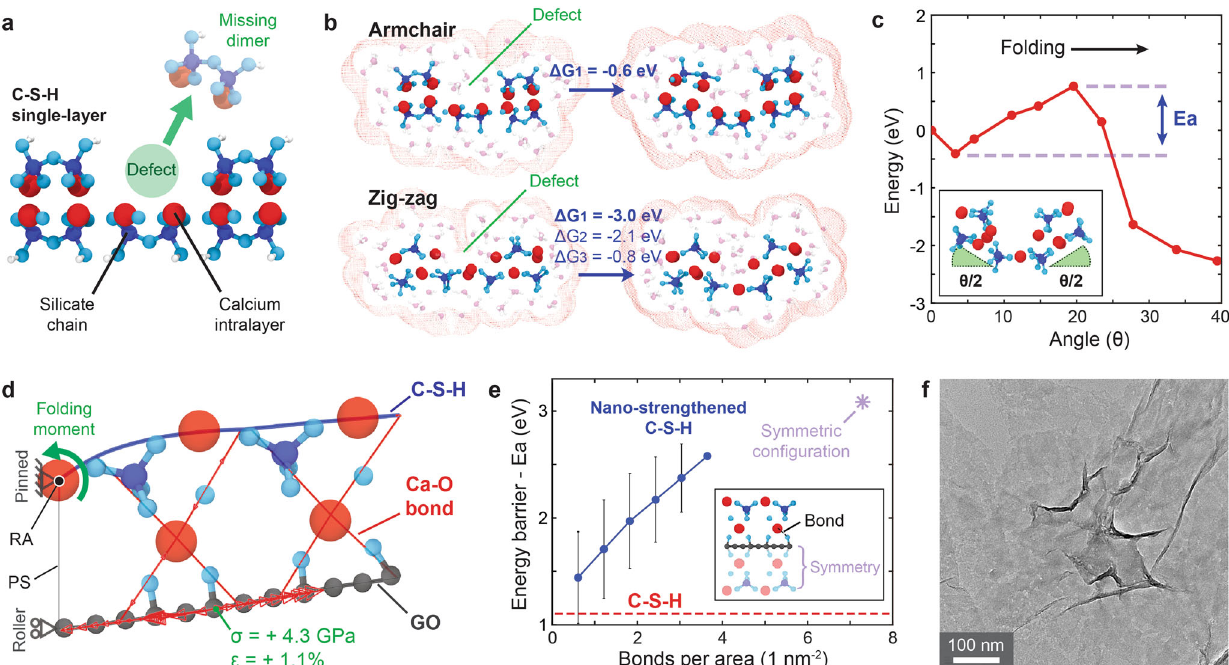
Fig. 7 Theoretical validation of the GO-strengthening mechanism for controlling the inherent spatial deformations of C – S – H sheets. a Atomic structure of a defective C – S – H single layer with a missing silicate dimer. b Free energy difference ( Δ G ) of the hinged C – S – H sheets before and after folding conformations, as calculated by DFT. c Energy path for C – S – H folding conformation with the highest Δ G , as calculated by the nudged elastic band method. The energy barrier ( E a ) is indicated. Inset: folding angle θ is de fi ned as the tilt displacement of the CaO layer (see Supplementary Fig. 12). d Snapshot of the FEM simulations showing the stress and strain in a GO-strengthened C – S – H layer as is deformed. C – S – H and GO are represented by two parallel beams connected via cross-bracing elements representing the Ca – O bonds. The model has symmetrical boundary conditions. RA rotation axis, PS plane of symmetry. e Energy barrier required to fold GO-strengthened C – S – H, as a function of the number of bonds per area. The energy barrier value (~1.17 eV) of the C – S – H without strengthening is marked with a dashed line. Inset: bonding between C – S – H and GO and the symmetrical con fi guration considered in the calculations. Error bars represent the standard deviation of at least six different con fi gurations (see Supplementary Fig. 15). Red, light-blue, dark-blue, white and dark-grey circles indicate the Ca, O, Si, H and C atoms, respectively. f TEM image showing the folding deformations of a C – S – H sheet on the surface of reduced